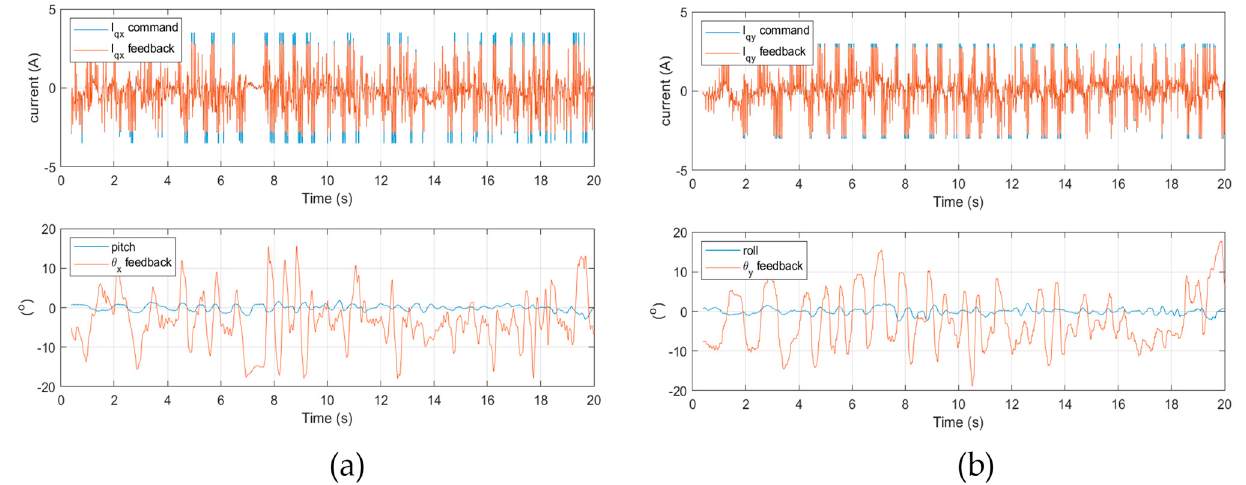
Figure 10. The experiment results for the position control of the HMDOF motor with the disturbance: ( a ) the control results of the roll motor; ( b ) the control results of the pitch motor.